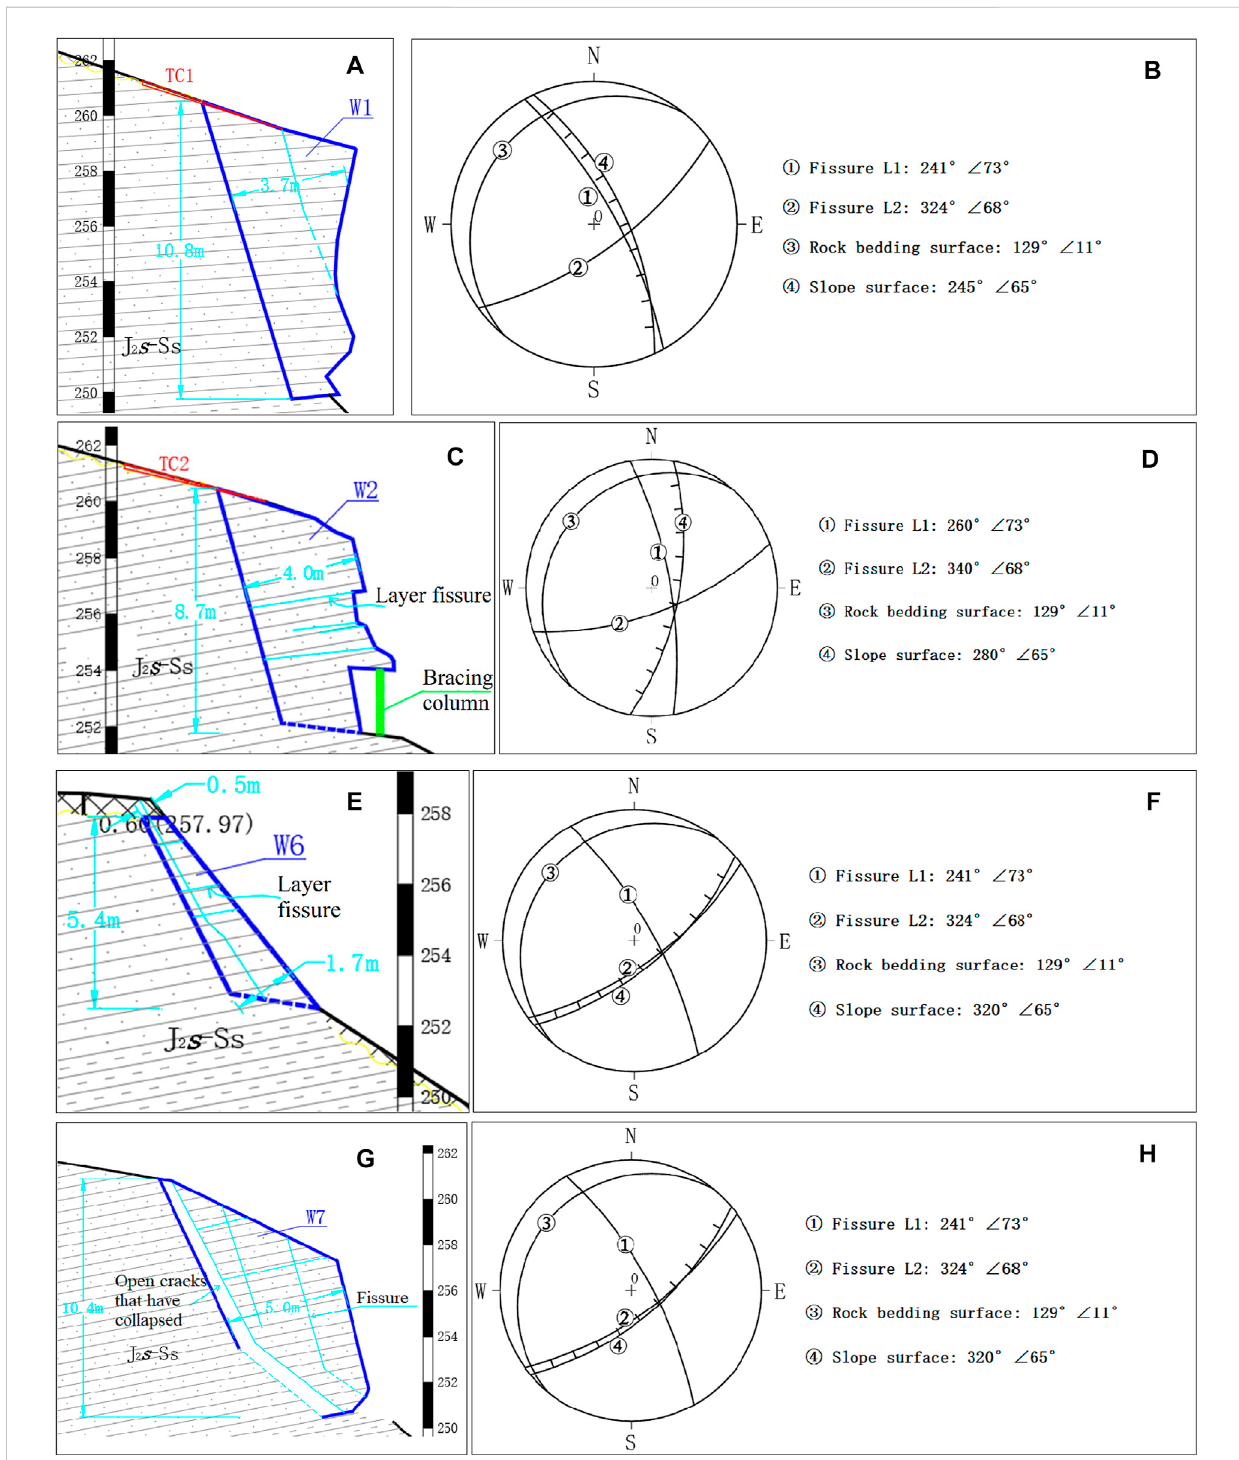
FIGURE 3 Qualitative analysis. (A) Section drawing of W1. (B) Stereographic projection fi gure of W1. (C) Section drawing of W2. (D) Stereographic projection fi gure of W2. (E) Section drawing of W6. (F) Stereographic projection fi gure of W6. (G) Section drawing of W7. (H) Stereographic projection fi gure of